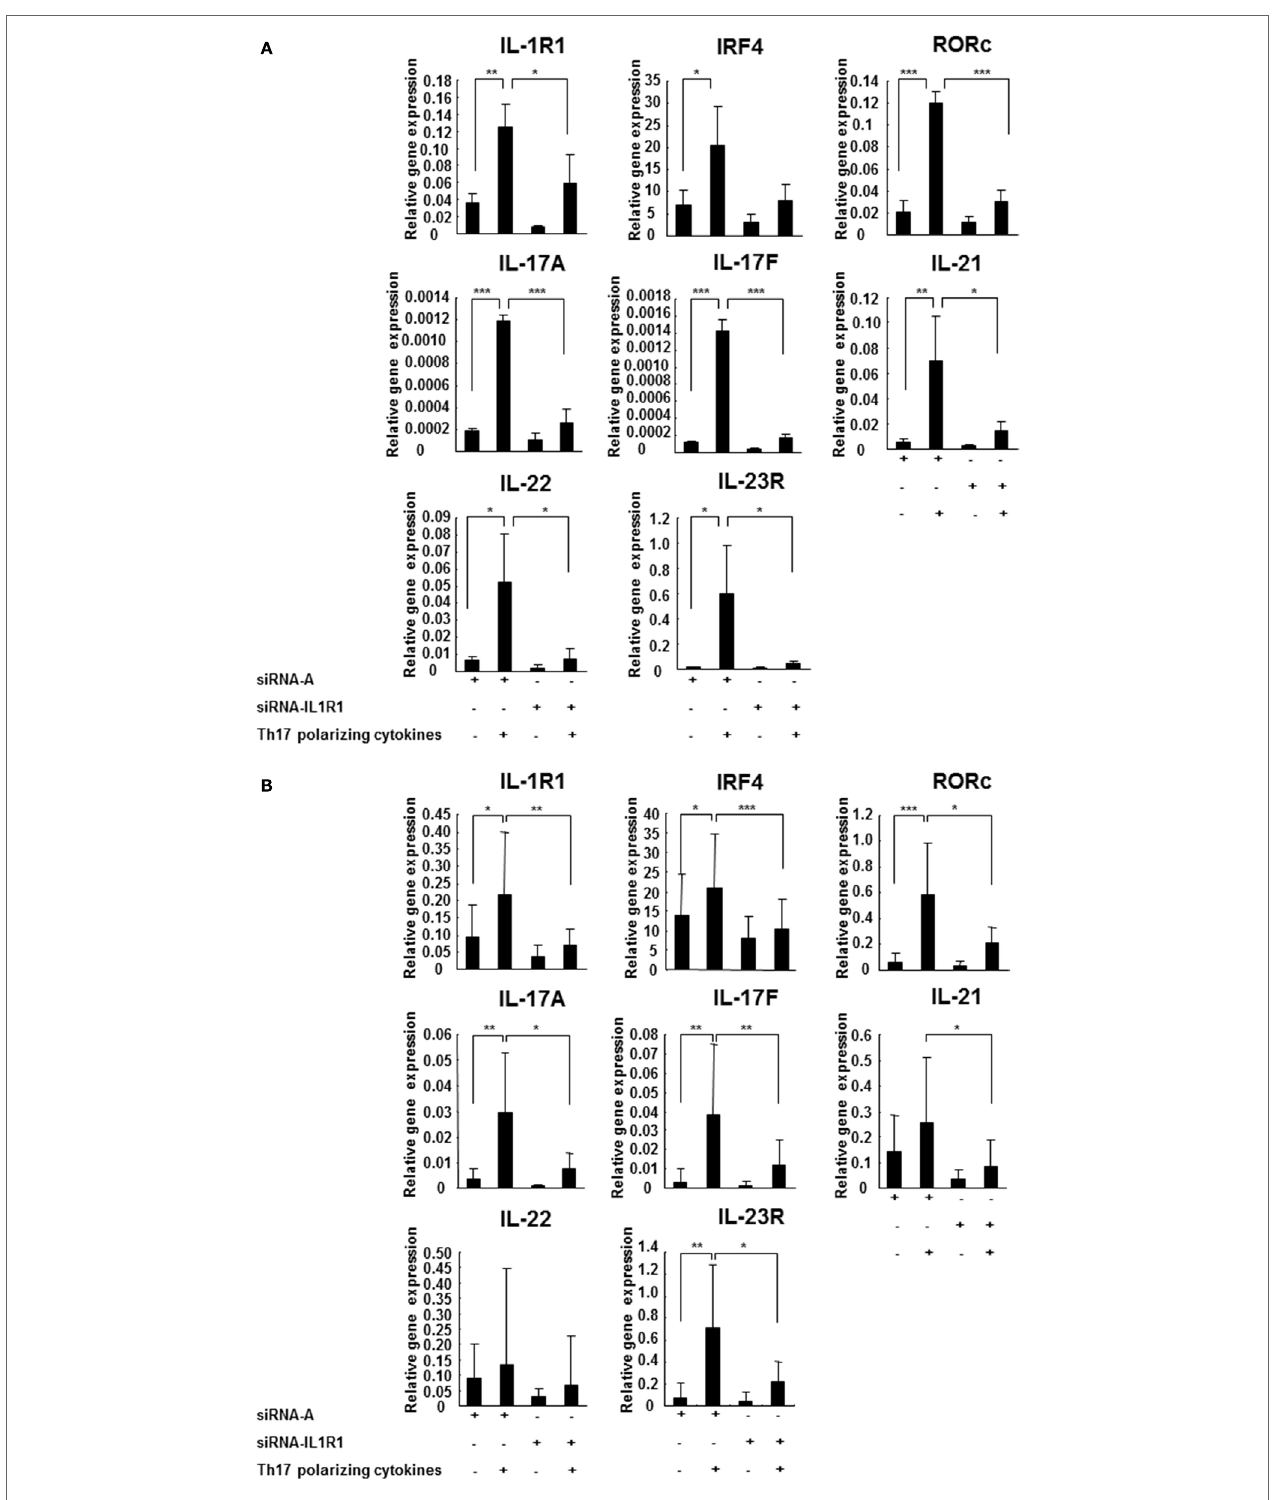
FigUre 3 | il-1r1 signaling induces Th17 cell differentiation . CD4 + CD45RA + cells were derived from three HCs (a) and seven RR MS patients (B) and transfected with a control siRNA A or siRNA IL-1R1, stimulated with plate-immobilized anti-CD3 and anti-CD28 mAb and cultured in serum-free medium in the absence or presence of Th17-polarizing cytokines. The total RNA was extracted at 72 h, and the expression of the indicated genes was measured using RT-PCR. The results are expressed as relative gene expression normalized against 18S mRNA expression. Statistical analysis was performed using repeated measures ANOVA, * p < 0.05, ** p < 0.01, *** p < 0.001.